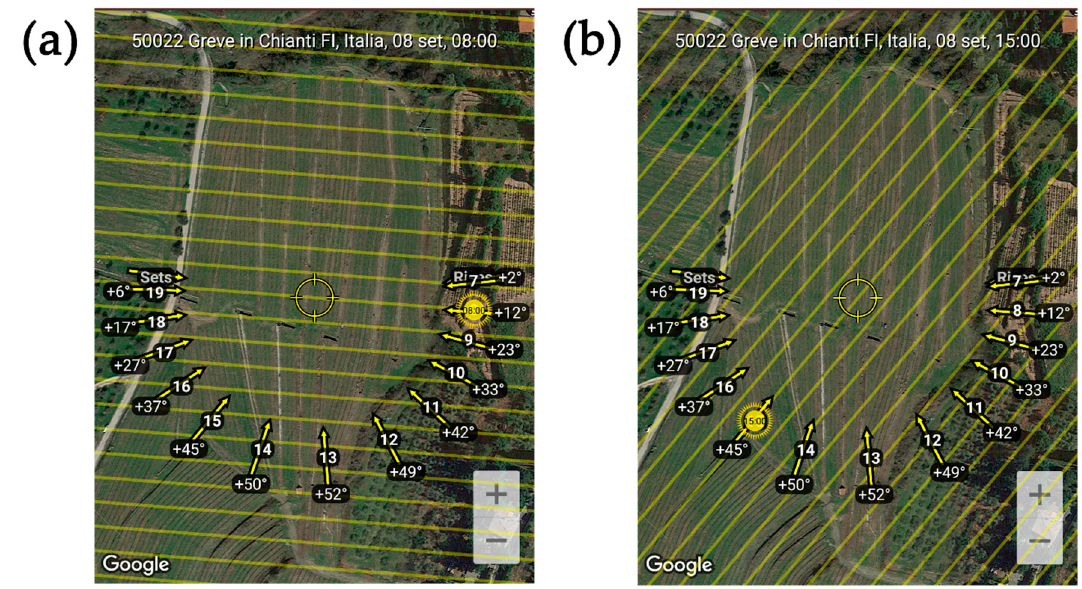
Figure 9. Sun position over the Grospoli vineyard on 8 September 2017, at ( a ) 08:00 CET (solar rays perpendicular to the rows) and ( b ) 15:00 CET (solar rays irradiating all the